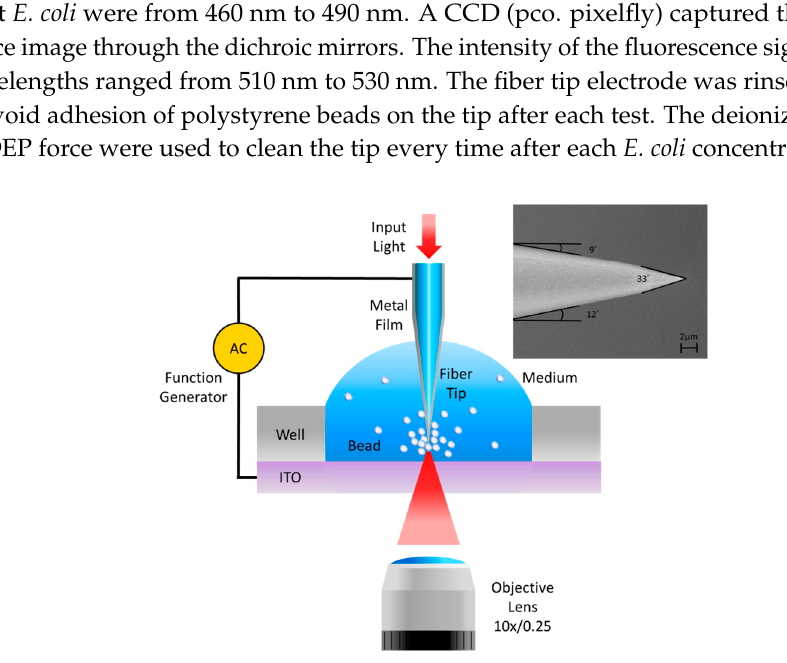
Figure 2. The optical setup for the measurement. A laser light passed through the chopper and coupled into the end of the fiber. The transmission light of the tip was received by an objective lens and detected by a photodetector. The function generator provided a sine function to the tip and ITO electrode. The inset shows SEM image of the fiber probe.